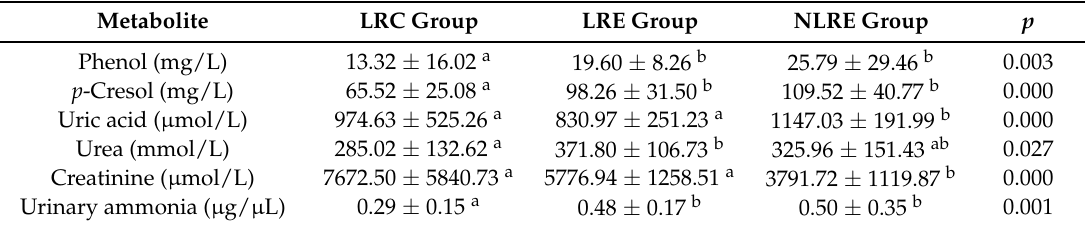
Table 4. Metabolites in urine in the LRC group, LRE group and NLRE group 1 .